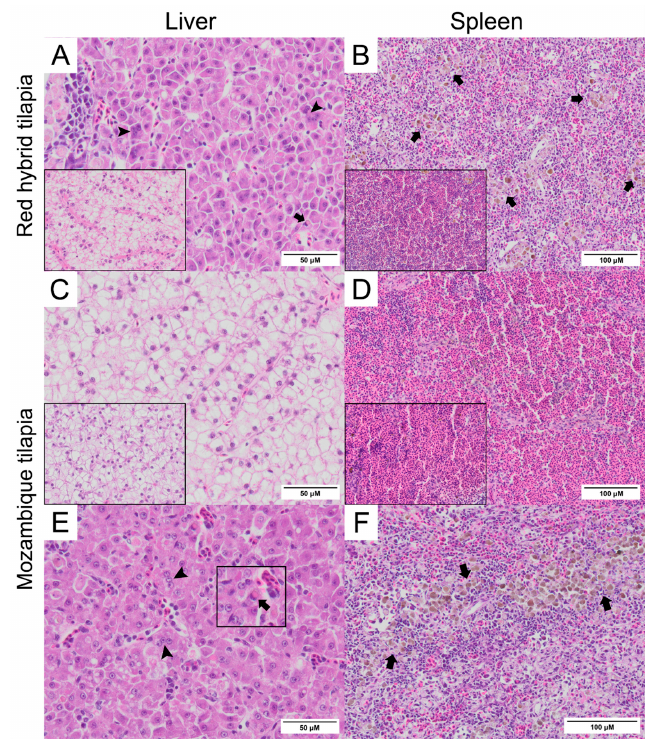
Figure 3. Histopathology of liver and spleen of red hybrid tilapia ( Oreochromis spp.) and Mozam- bique tilapia ( Oreochromis mossambicus ) after 6 days post TiLV challenged. ( A ) Liver of red hybrid tilapia challenged with high TiLV concentration; depletion of glycogen, syncytial cells formation (arrowheads) and intracytoplasmic inclusion bodies (arrows), normal liver (inlet). ( B ) Spleen of red hybrid tilapia challenged with high TiLV showed depletion of red blood cells and increased mela- nomacrophage centers (MMCs) (arrows), normal spleen of red hybrid tilapia (inlet). ( C ) Liver of Mozambique tilapia challenged with low TiLV concentration, normal liver of Mozambique tilapia (inlet). ( D ) Spleen of Mozambique tilapia challenged with low TiLV concentration, normal spleen of Mozambique tilapia (inlet). ( E ) Liver of Mozambique tilapia challenged with high TiLV concen- tration; glycogen depletion, syncytial giant cells contained multiple nuclei (arrowheads) and intra- cytoplasmic inclusion bodies (inlet, arrows). ( F ) Spleen of Mozambique tilapia challenged with high TiLV concentration, infiltration of MMCs (arrows).